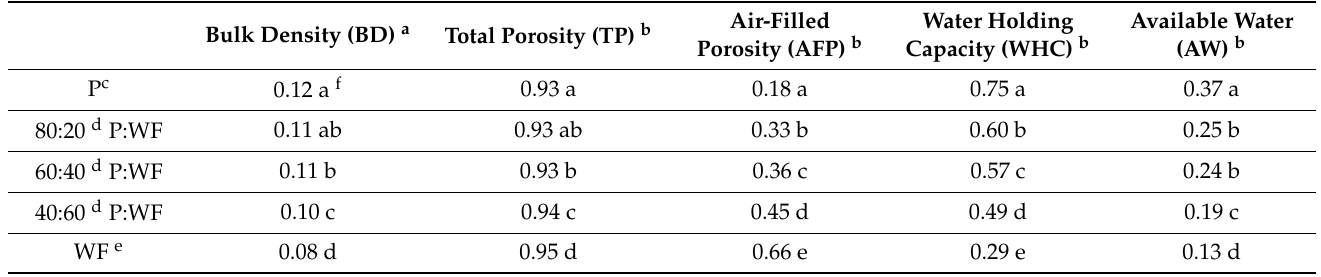
Table 4. Main physical properties calculated for peat, wood fiber and mixes peat:wood fiber from water retention